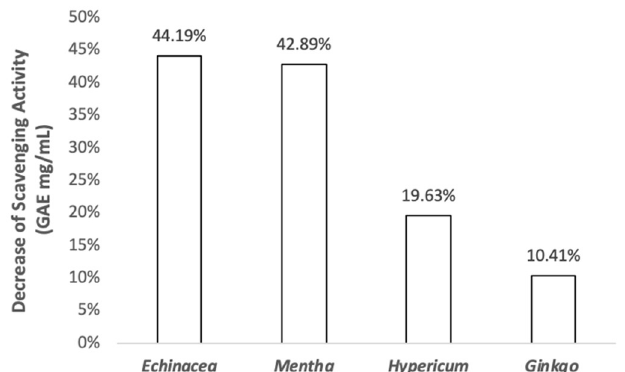
Figure 7. Percent decrease in scavenging affect after 30 min of oxidation obtained in the oxidation stress test for each analyzed MT.